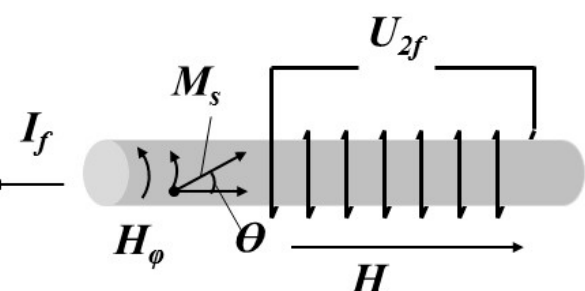
Figure 1. Schematic configuration of a microwire with a pick-up coil, external applied magnetic fields, microwire magnetization, and measured response.